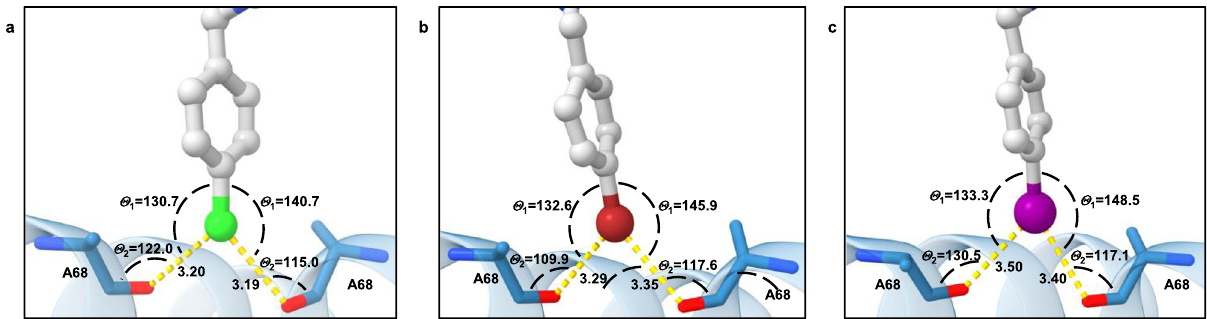
Fig. 2 Prediction of halogen bonding for compounds 4 – 6. Simulation snapshots depicting the ability of halogen bonding propensity for compounds 4 – 6 by averaging MD resulted interatomic X···O distances [Å] and θ 1 [C-X···O], i.e., θ 2 [X···O = C] angles calculated over the entire simulation trajectories between backbone carbonyl oxygen of Ala68 (represented as sticks colour coded by element) from both GyrA subunits (cartoon representation in blue; PDB ID: 2XCS) 10 and our studied p -halogenated RHSs: a p -chlorophenyl ( 4 , chlorine atom in green); b p -bromophenyl ( 5 , bromine atom in red); and c p -iodophenyl ( 6 , iodine atom in